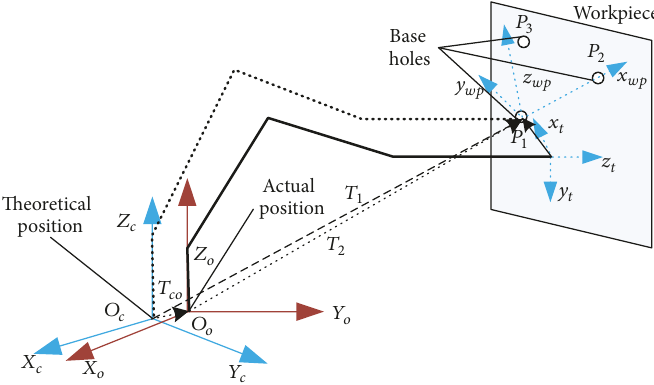
Figure 6: Base detection theorem of three-base